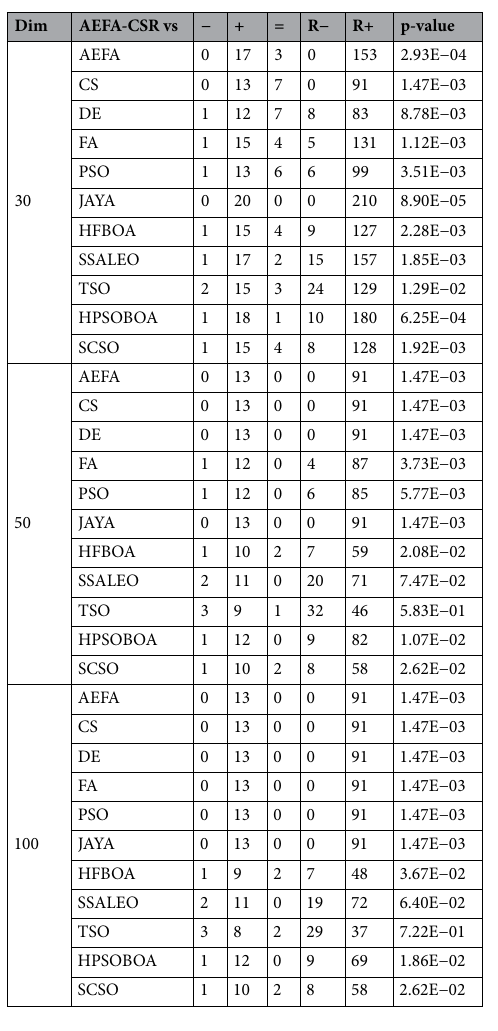
Table 9. Wilcoxon Rank sum test 30 , 50 and 100 dimensions for 20